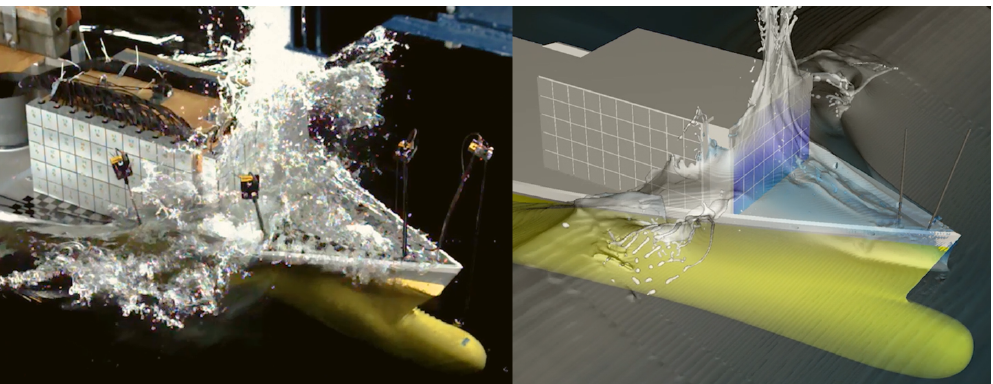
Figure 1. Numerical reproduction of green water experiment (more details in Section